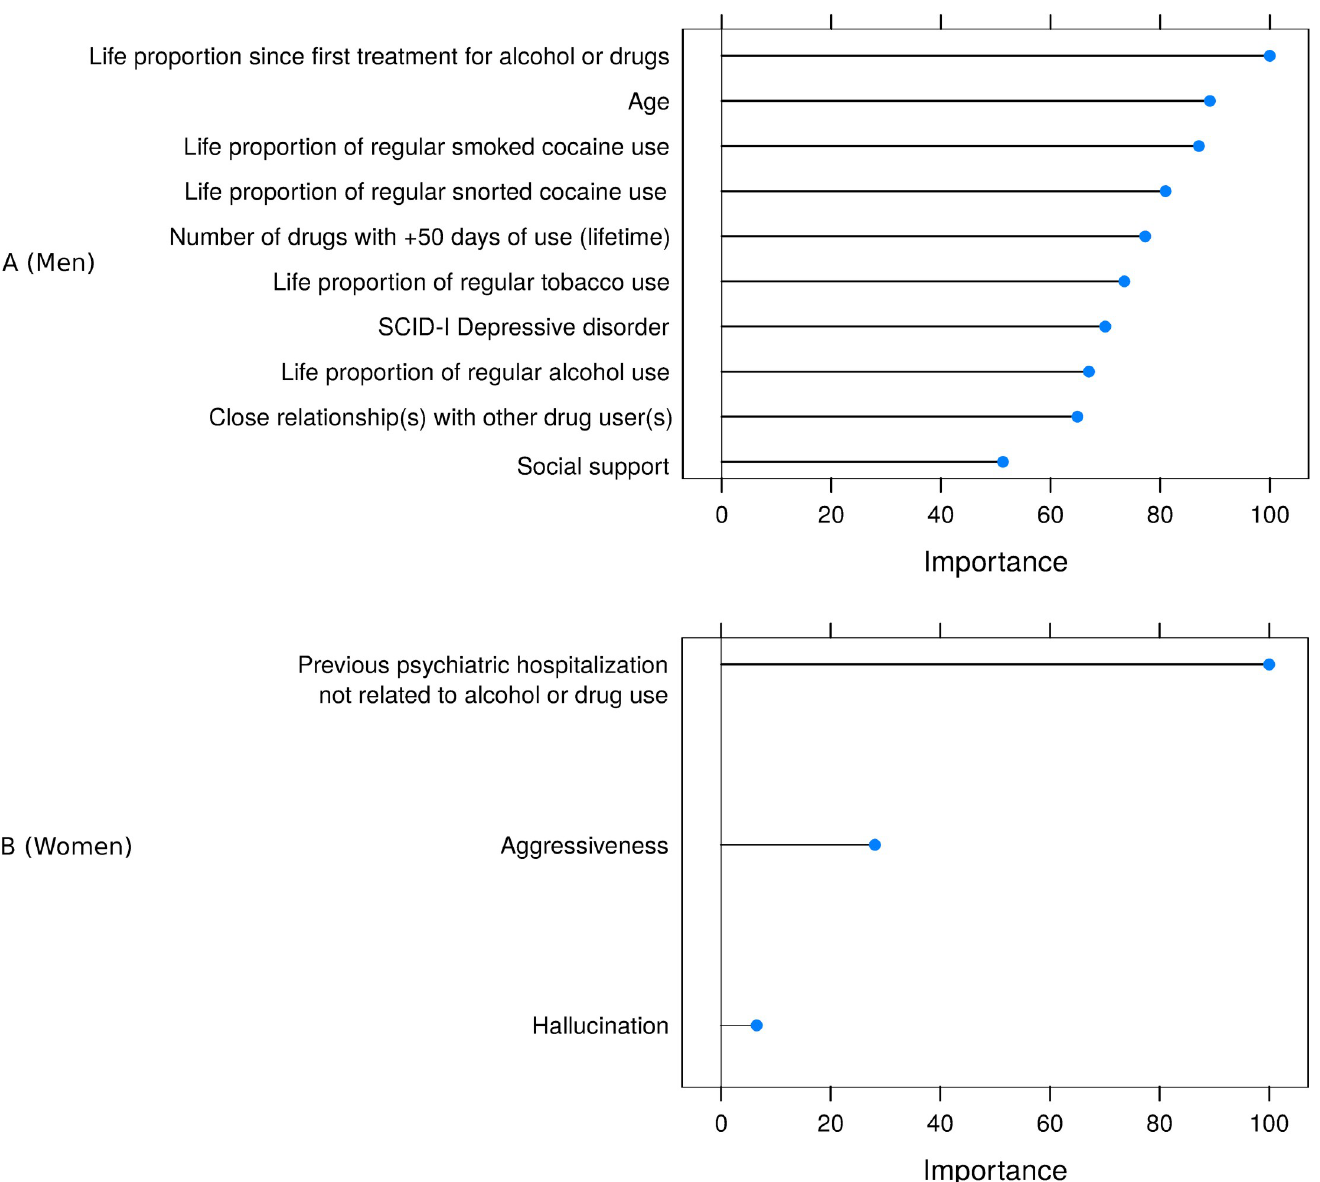
Fig 2. ROC curves for the predictive models of attempted suicide plotted on the test data for each Random Forest learned model—men (A; n = 50) and women (B; n = 90). The dot indicates the sensibility and specificity at whitch the distance between the curve and the transversal line is the largest.